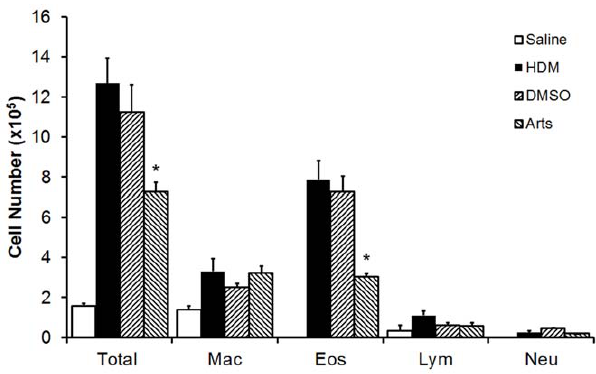
Figure 7. Effects of artesunate on house dust mite extracts- induced pulmonary inflammatory cell recruitment. Inflammatory cell counts in BAL fluid obtained from mice 72 hours after the last house dust mitechallenge (n=6 mice) markedly increased as compared to saline control (n=4 mice). Artesunate (30 mg/kg, n=6 mice) significantly suppressed house dust mite-induced increases in BAL fluid total cell and eosinophil counts as compared with vehicle control (DMSO, n=5). Differential cell counts were performed on a minimum of 500 cells to identify (Eos), macrophage (Mac), neutrophil (NEU), and lymphocyte (Lym). *Significant difference from DMSO control, p ,